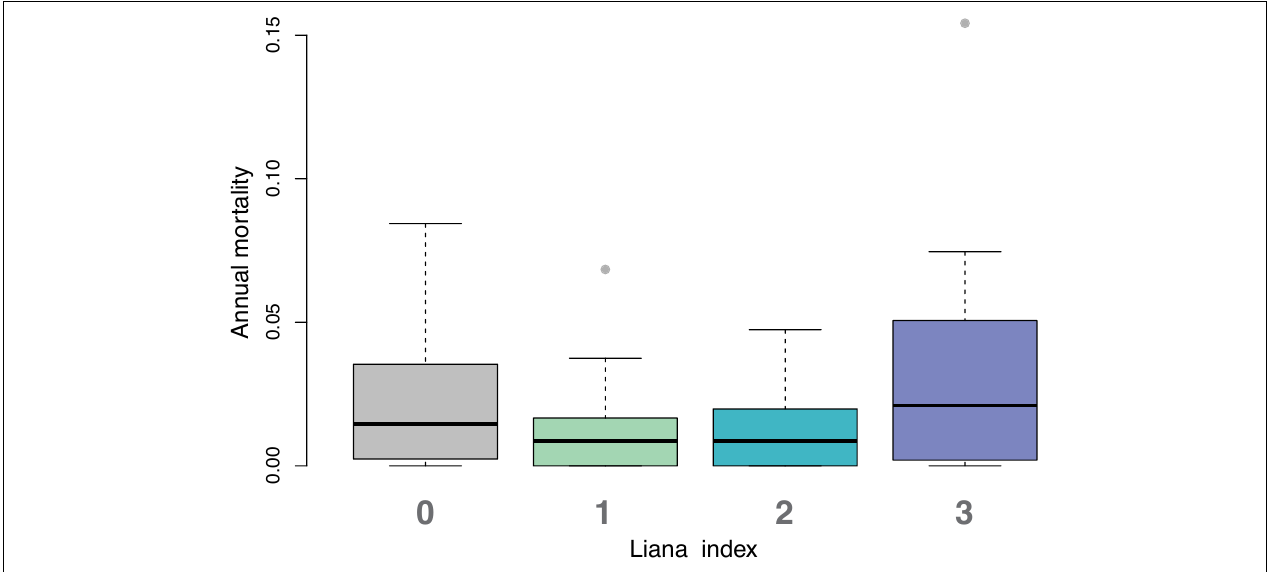
FIGURE 4 | Distributions of annual mortality rate for each liana index value. Each box and whisker plot represents 11 points, one from each year. The median annual mortality rate for liana level 3 (lianas present in more than 50% of the tree’s crown) is highest. But non-parametric comparison of means test shows no significant differences among